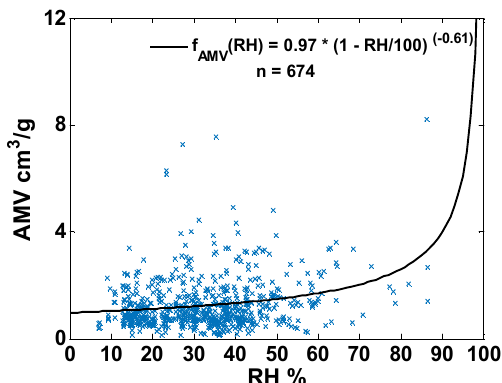
Figure 9. Simulation results of f AMV (RH) for the Beijing area.